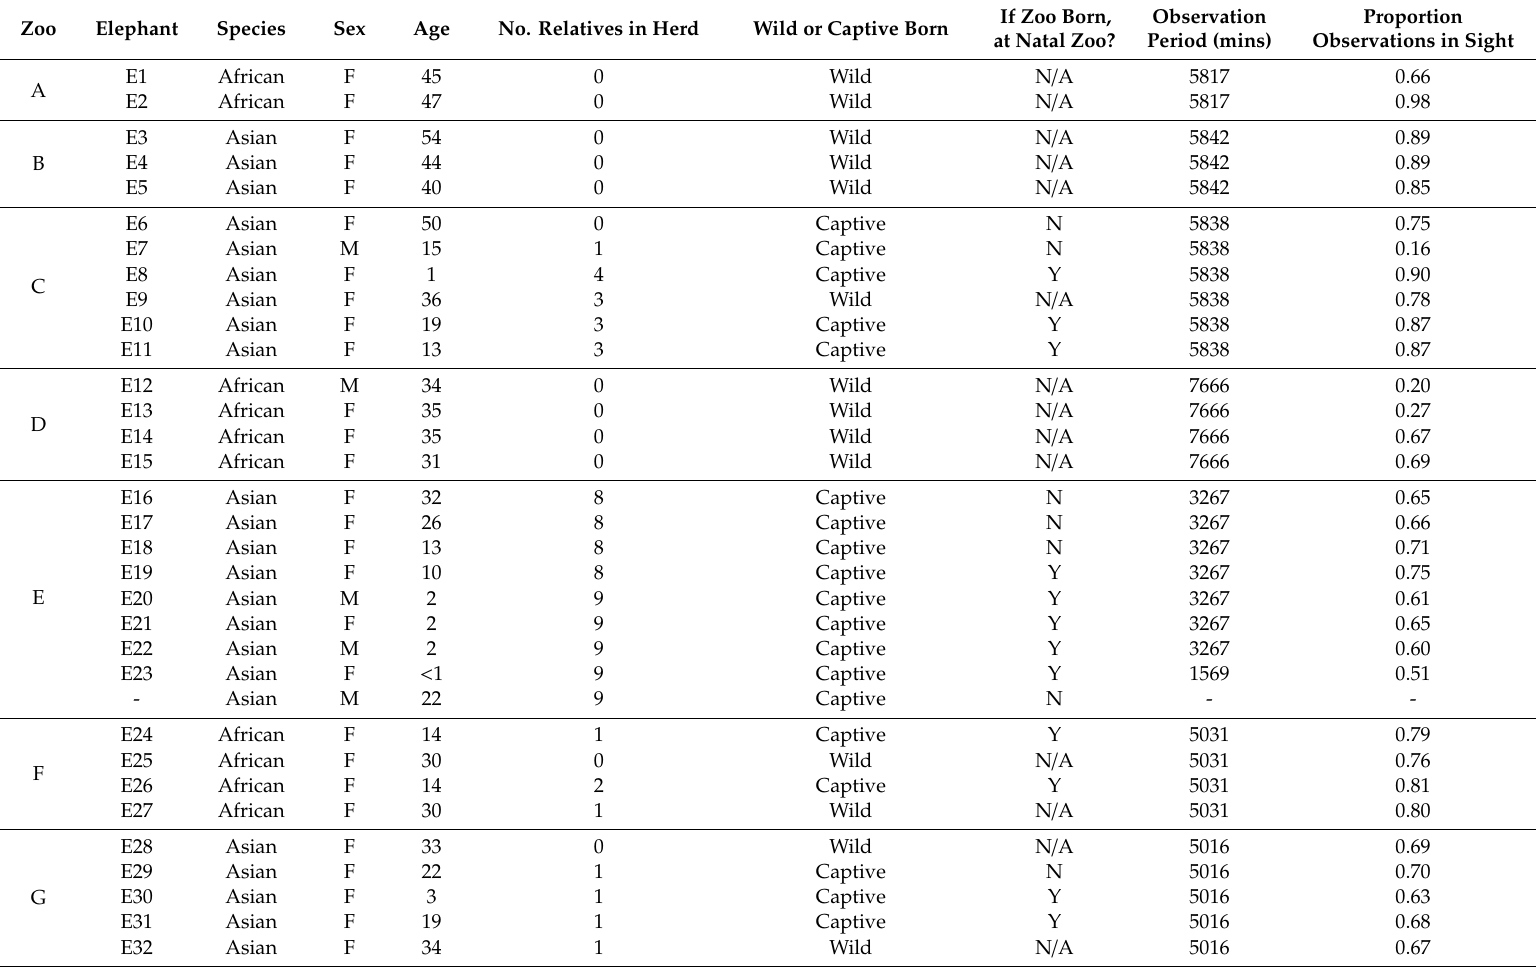
Table 1. Elephant and herd demographics for the study elephants at the onset of the study period (October